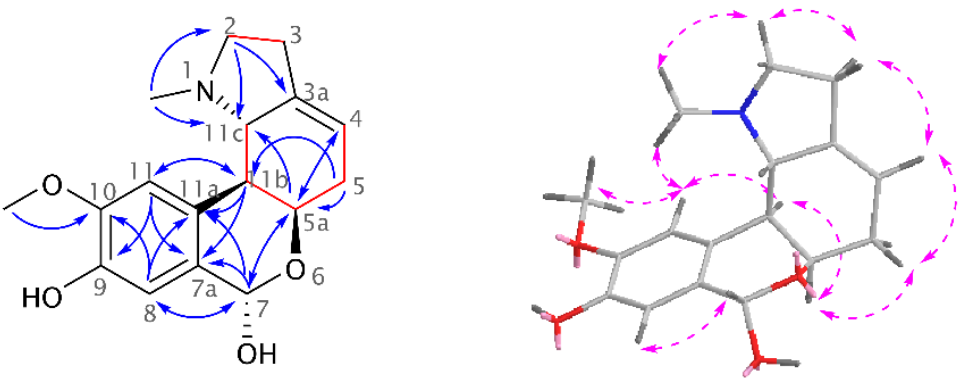
Figure 1. Structural elucidation of 1 showing key gCOSY, gH2BC (red lines), gHMBCAD (blue arrows), and NOESY (pink dashed arrows) correlations.